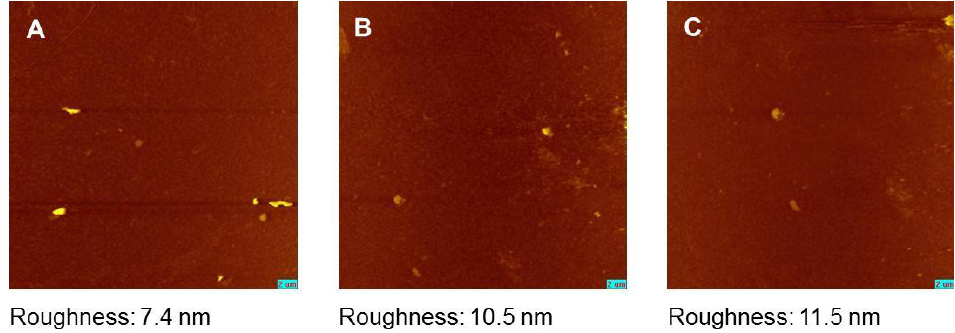
Figure 4. Comparison of trehalose protected and unprotected DSPC model membranes by SPFM. Unprotected DSCP membranes in aqueous surrounding ( A ) are comparable to trehalose protected dry DSPC membranes ( B ) and those after rehydration ( C ). Inserted bars represent 2